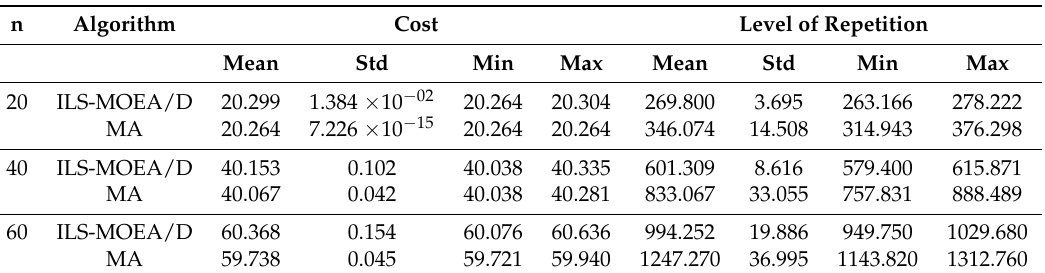
Table 3. Statistics for the cost and level of repetition achieved by ILS-MOEA/D and MA, considering menu plans for n = 20, n = 40 and n = 60 days.